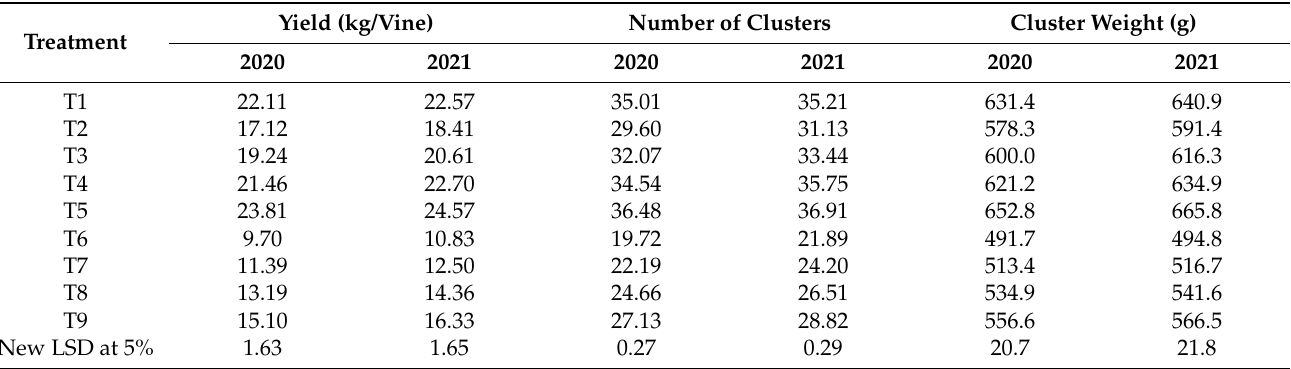
Table 4. Effect of mineral fertilizer alone or combined with superabsorbent polymer (SAPs) on yield components of Autumn Royal grapevines in 2020 and 2021 seasons.